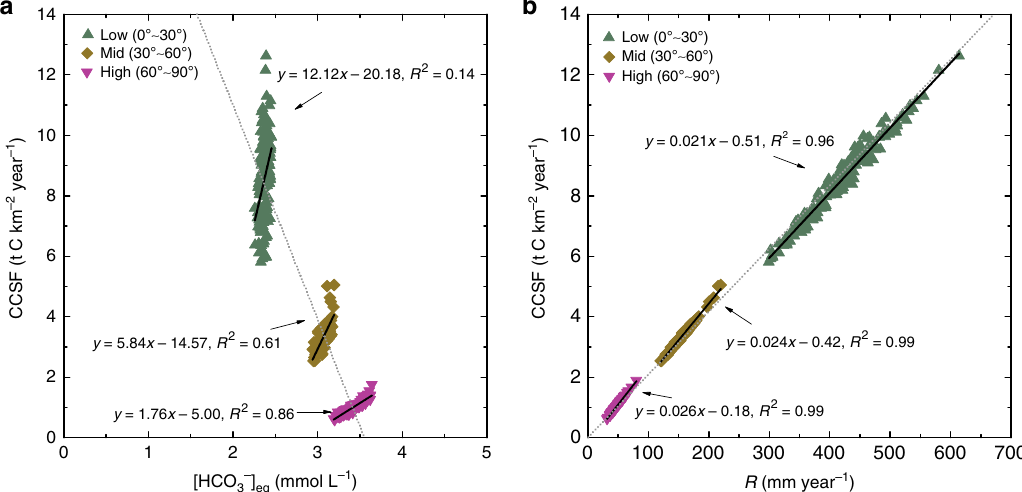
Fig. 6 Relationship between CCSF and relevant variables. a CCSF (carbonate weathering carbon-sink fl ux) and [HCO 3 − ] eq , and b CCSF and R (runoff) in the historical period (1950 – 2005), normalized into three global latitudinal zones. Runoff dominates the CCSF variation across different latitudinal zones. [HCO 3 − ] eq shows a high ( R 2 = 0.86) positive relation with CCSF only in high latitudes (60° – 90°), where runoff is low.